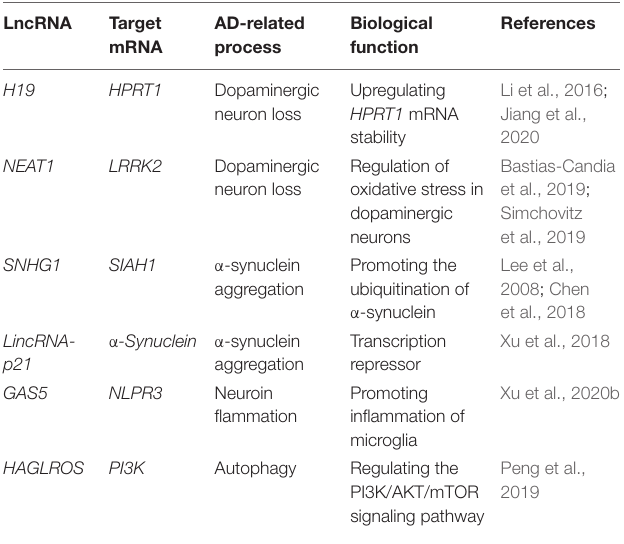
TABLE 2 | Main dysregulated long non-coding RNAs in Parkinson’s